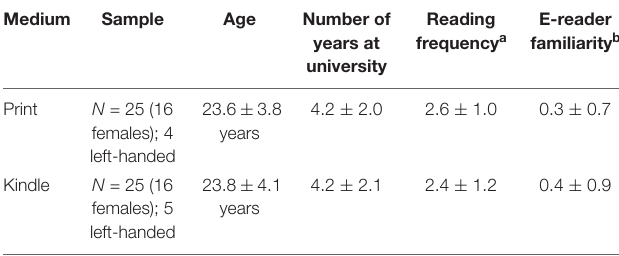
TABLE 1 | Descriptive statistics: demographics and reading habits.